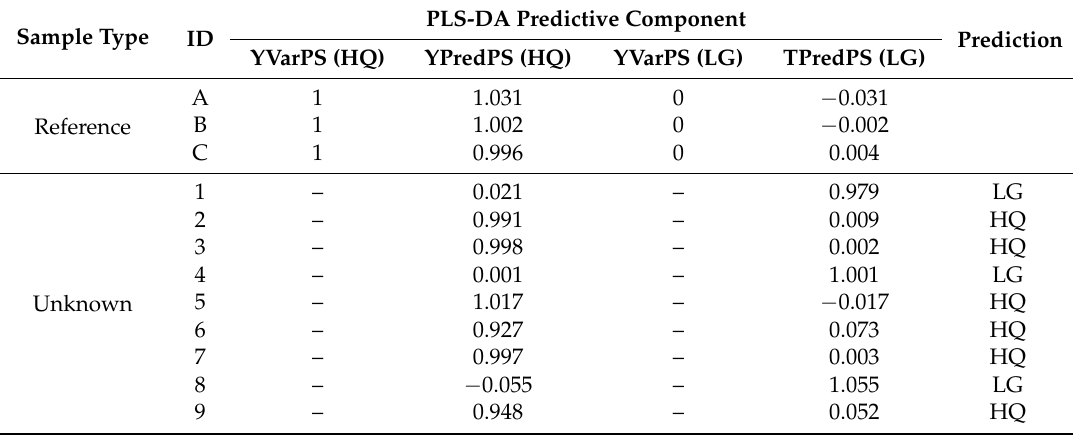
Table 3. Predictive component of the PLS-DA model when applied for three unknown lavender oil samples.